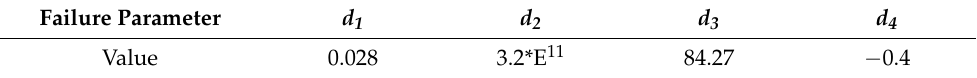
Table 5. Failure parameters d 1 − d 4 used in the JC damage criterion (obtained with tensile tests). Failure